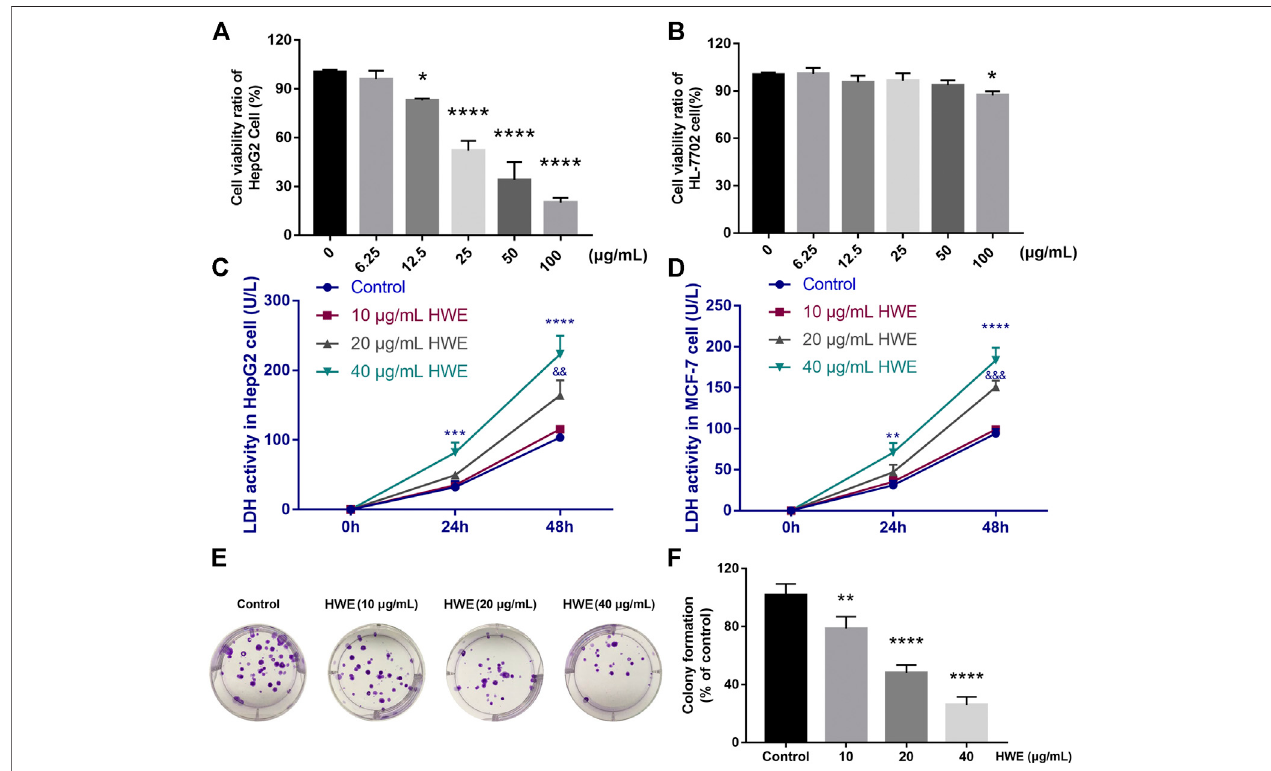
FIGURE5| EffectofHWEonHepG2cellviabilityandLDHrelease. (A) CellviabilityofHepG2cellswithorwithoutHWEtreated (B) CellviabilityofHL-7702cellswith orwithoutHWEtreated. (C,D) LDHactivityinHepG2andMCF-7cellswithorwithoutHWEtreatedat24and48 h. (E,F) GrowthinhibitioneffectsofHWEonHepG2cells were measured by colony formation assay. Error bars represent SD. * p < 0.05, ** p < 0.01, **** p < 0.0001 vs. control